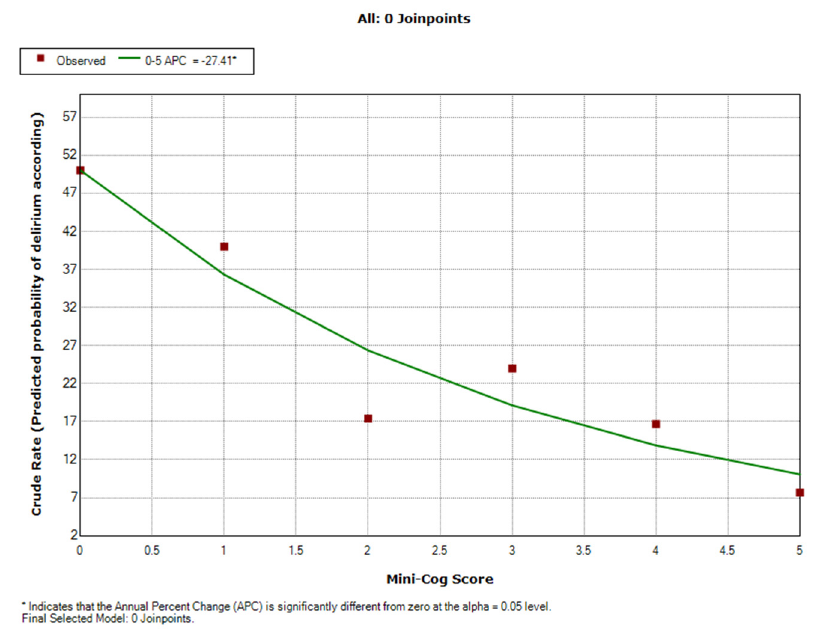
Figure 5. Scatter plot of the predicted probability of postoperative delirium according to preoperative cognitive impairment (Mini-Cog score). Table 5. Age-adjusted univariate and multivariate logistic regression analyses to identify predictors for post-operative delirium. Post-Operative Delirium Age-Adjusted vs.